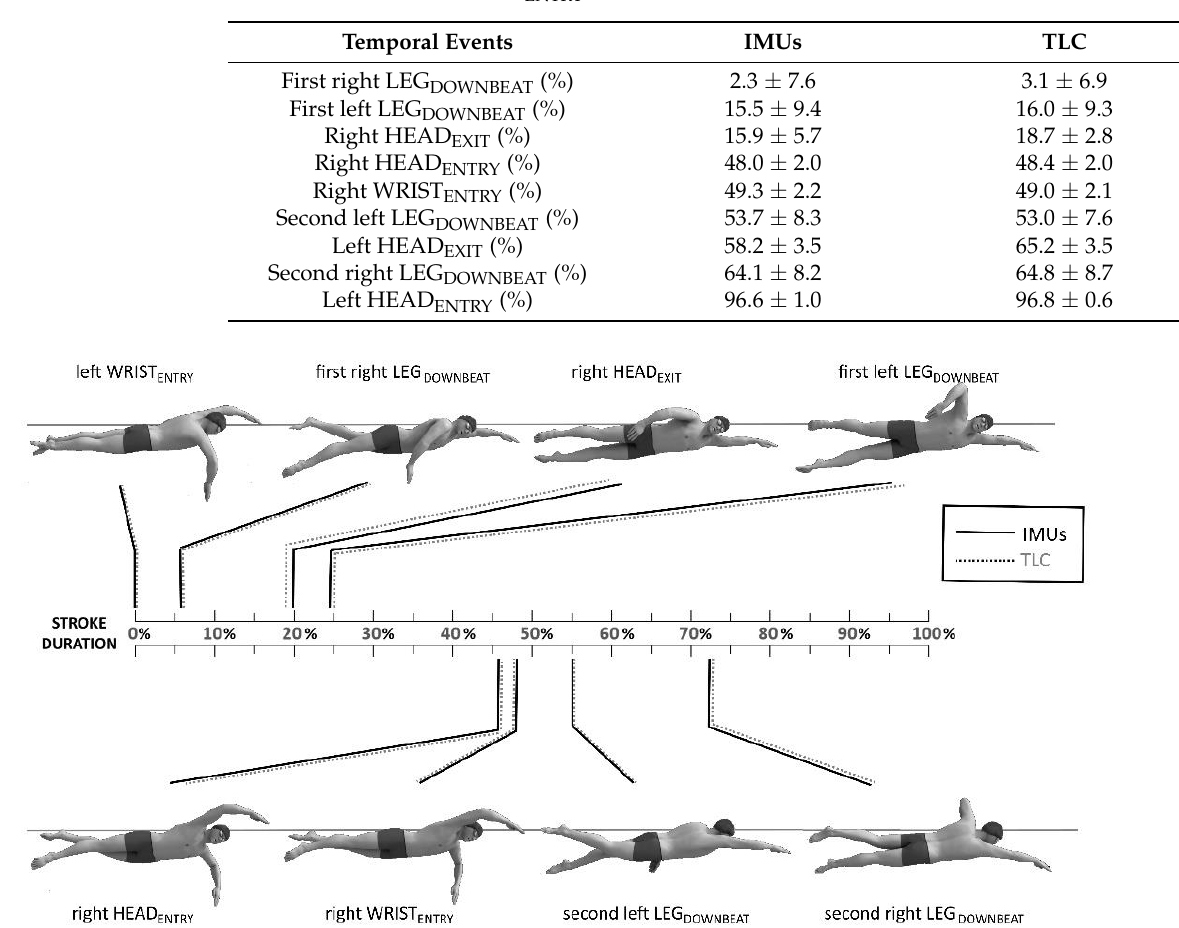
Figure 4. The timing of the analyzed temporal events in percentage of the stroke duration using IMUs (solid black lines) and video-based technique (TLC, dotted grey lines) for a single participant. The stroke duration was normalized to left WRIST ENTRY events. The ticks in the stroke duration axis correspond to 5%.